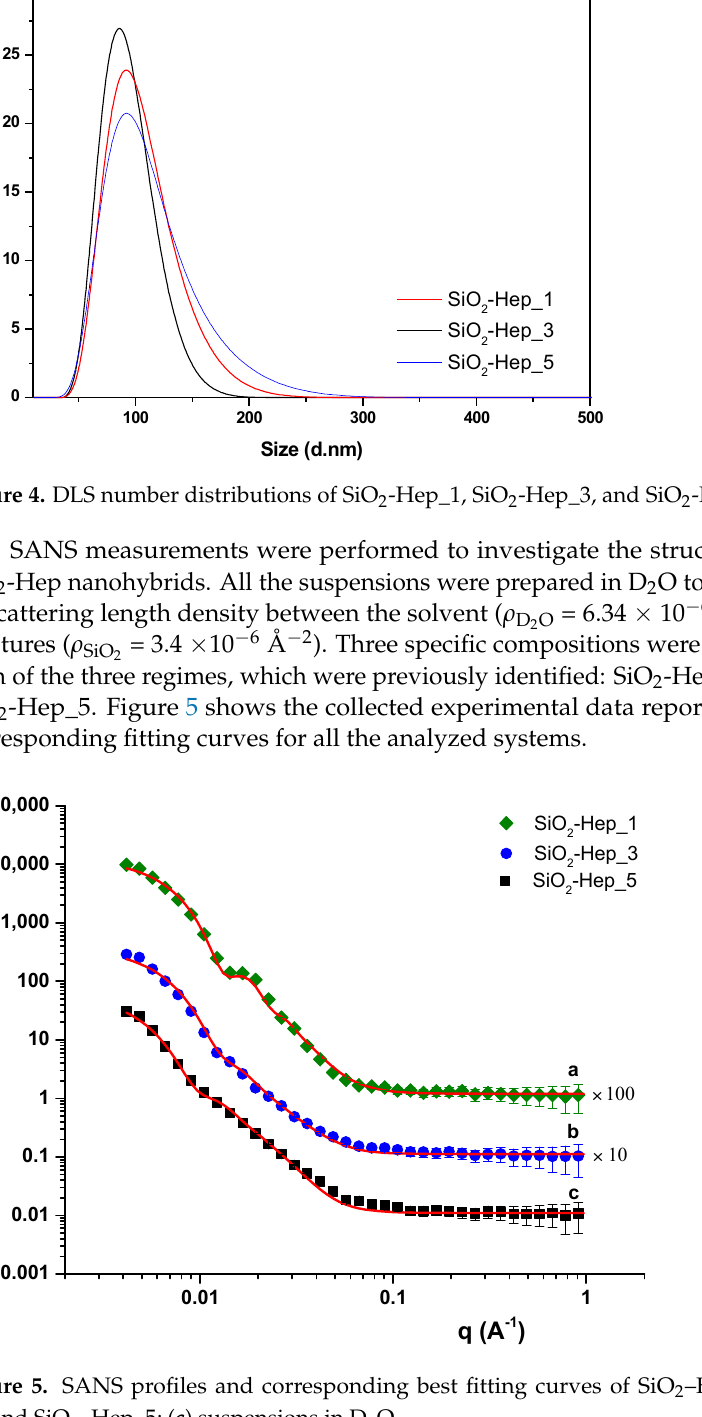
Figure 5. SANS profiles and corresponding best fitting curves of SiO 2 –Hep_1 ( a ), SiO 2 –Hep_3; ( b ) and SiO 2 –Hep_5; ( c ) suspensions in D 2 O.